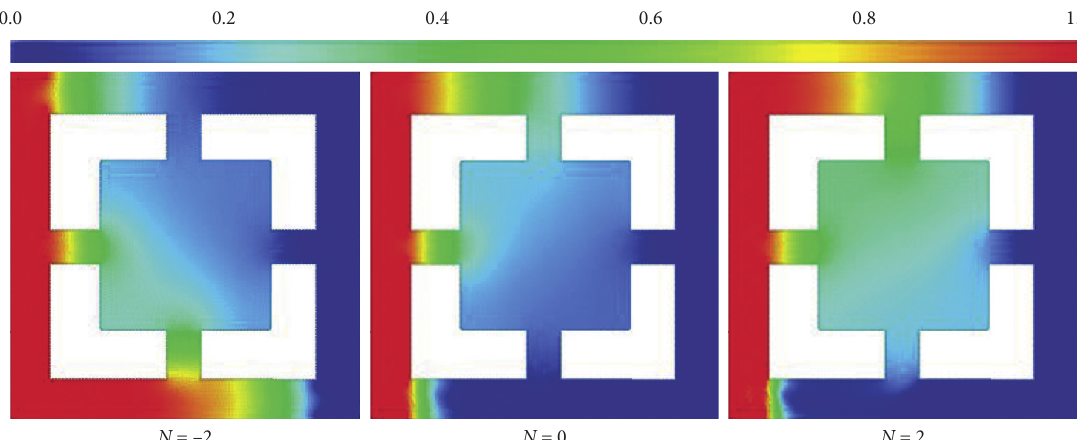
Figure 4: Features of concentration below the variations in a buoyancy ratio parameter at Ra � 10 4 , ϕ � 0 . 01 , Da � 10 − 3 , η ε � 0 . 6 , Le � 20, and τ � 1.